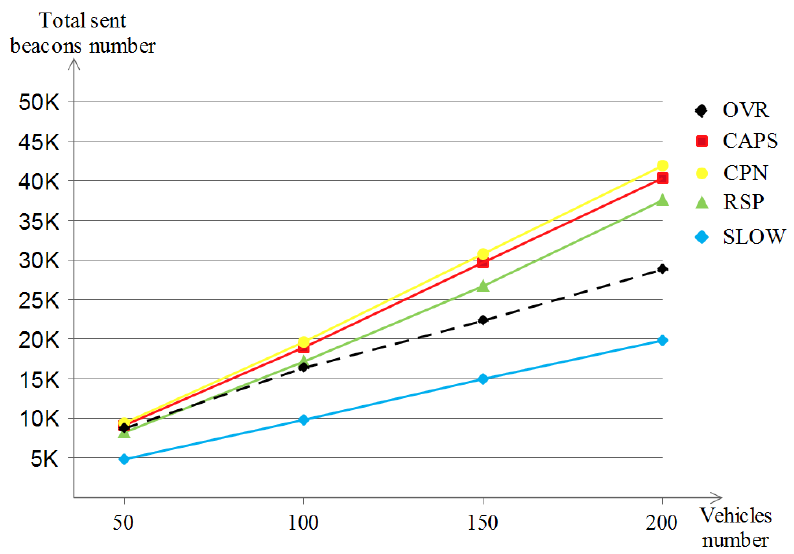
Figure 18. Sent beacons number of privacy schemes in the Manhattan scenario.